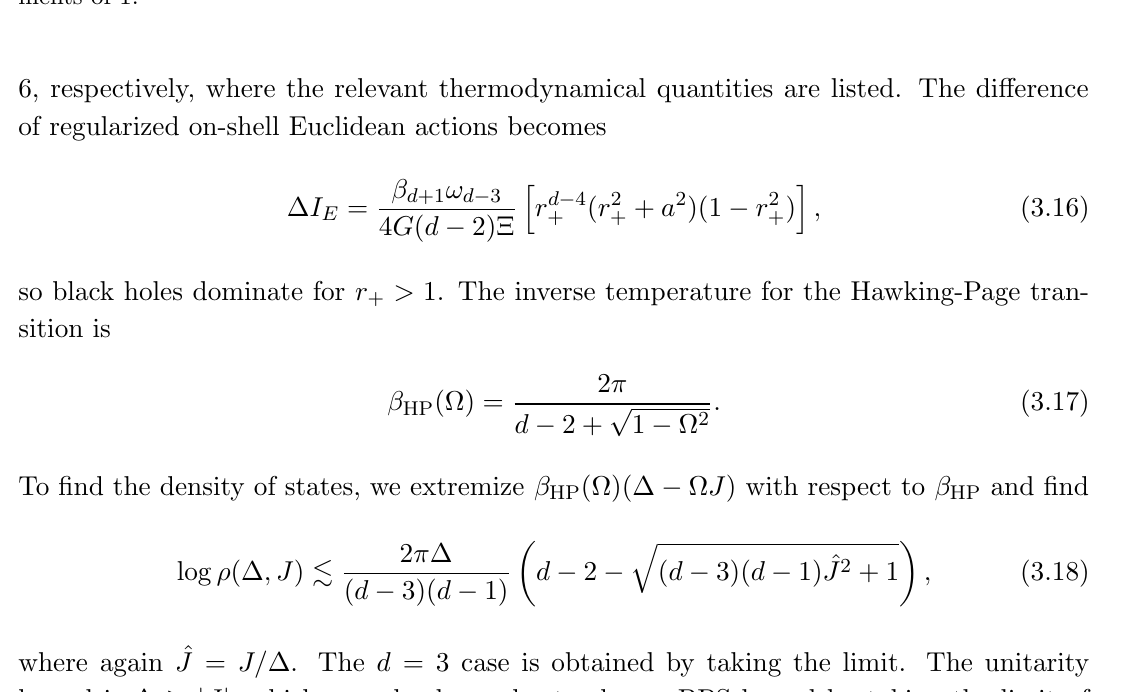
Figure 2. The bound for operators with spins J a and J b in d = 4 (left), d = 5 (middle), d = 6 (right). Curves correspond to J b = (cid:1) = 0 (rightmost) to J b = (cid:1) = : 9 (leftmost) in incre- ments of